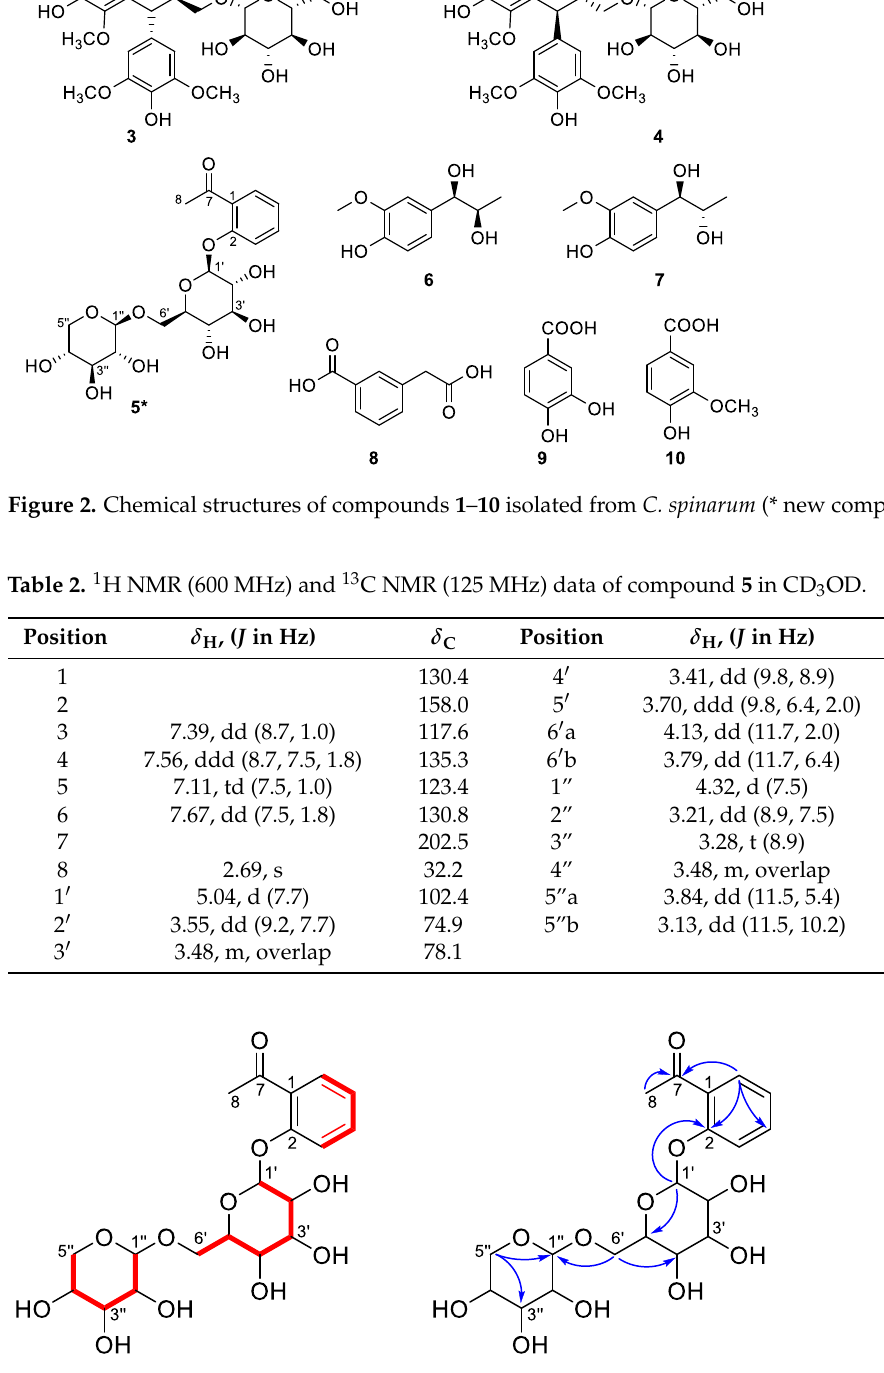
Figure 3. Key 1 H – 1 H COSY ( ) and HMBC ( → ) correlations of compound 5 .